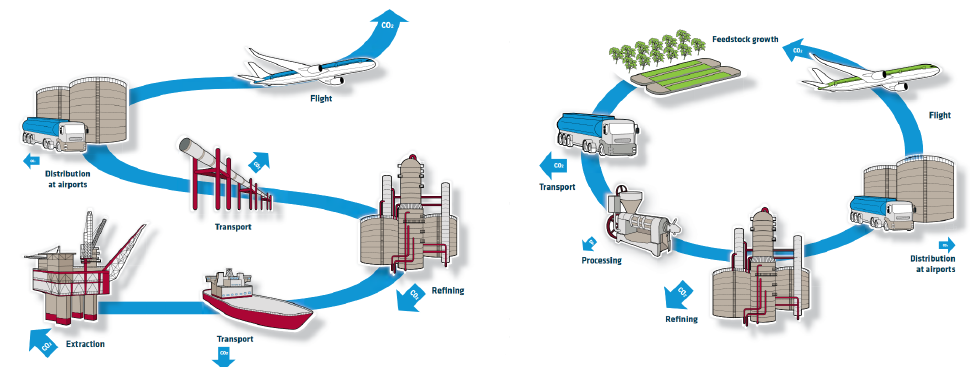
Figure 5. Carbon life cycle diagram for fossil jet fuel (left) and sustainable biofuel (right). Adapted from